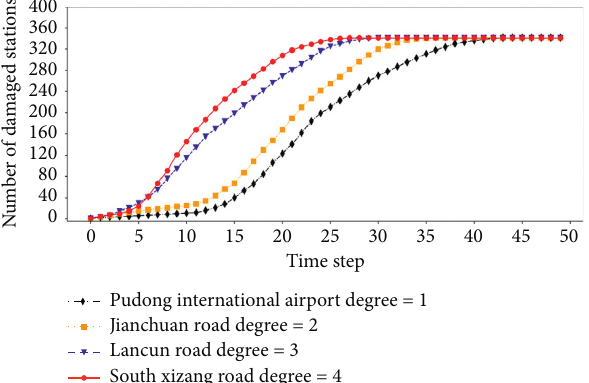
Figure 3: Network cascading failure processes caused by stations of different degrees ( R � 4, ε � 0.2).